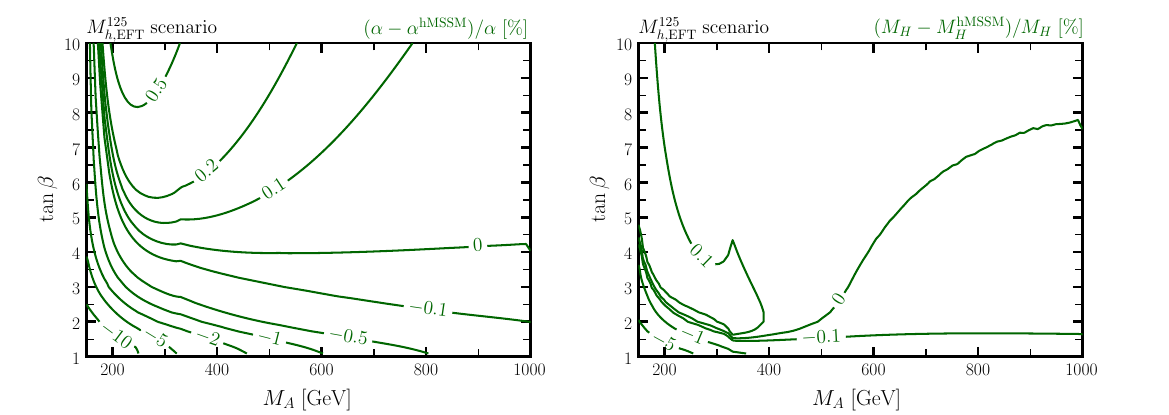
theheavy CP -evenHiggs-bosonmass M H betweenthe M 125 and the hMSSM approach in scenario and the h , EFT